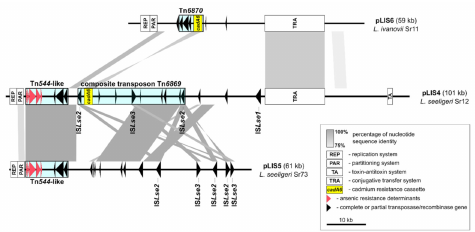
Figure 2. Comparative analysis of plasmids pLIS4 ( L. seeligeri Sr12), pLIS5 ( L. seeligeri Sr73) and pLIS6 ( L. ivanovii Sr11). Plasmid sequences were aligned and visualized using EasyFig. Gray shading indicates conserved DNA regions with at least 75% nucleotide sequence identity of at least 1 kb in length. A simplified structure of the plasmids is presented, showing only the putative REP, PAR, TA, TRA modules, partial or complete transposase / recombinase genes and heavy-metal resistance